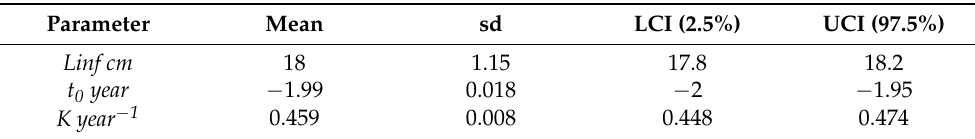
Table 6. Bayesian VBG fitting of the selected years (2009–2015 excluding 2011), model parameter estimates with their standard error (sd), lower (LCI), and upper (UCI) confidence intervals. Parameter Mean sd LCI (2.5%) UCI (97.5%) Linf cm 18 1.15 17.8 18.2 t 0 year − 1.99 0.018 − 2 − 1.95 K year − 1 0.459 0.008 0.448 0.474 Natural mortality (M) was obtained according to Gislason’s model, with relative lower and upper con fi dence intervals for each age class, particularly 0.99 (0.98 − 1.02) y − 1 at